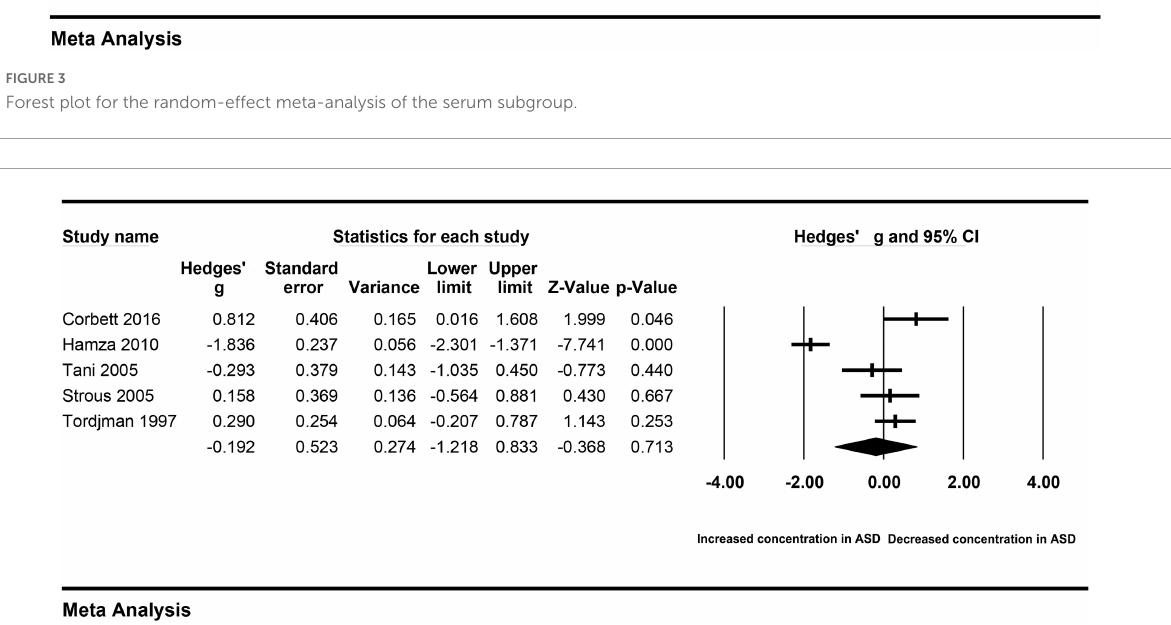
FIGURE4 Forest plot for the random-effect meta-analysis of the plasma